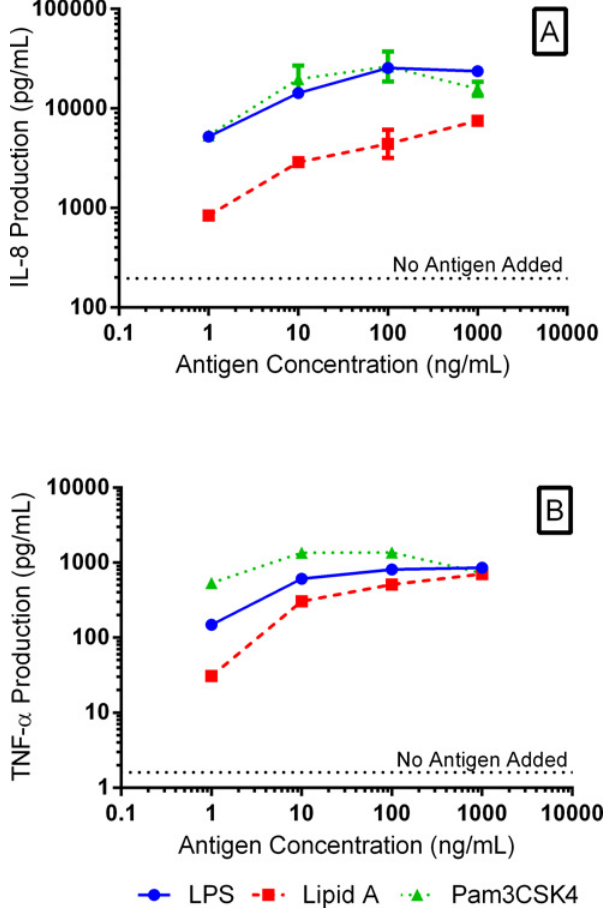
Fig 2. THP-1 Cytokine Response to Test Antigens. THP-1 monocytes were extremely sensitive to activation by LPS, Lipid A, and Pam3CSK4. Production of IL-8 (A) and TNF-a (B) was observed at antigen concentrations as low as 1 ng/mL and cytokine production increased with increasing antigen concentration in a dose-dependent